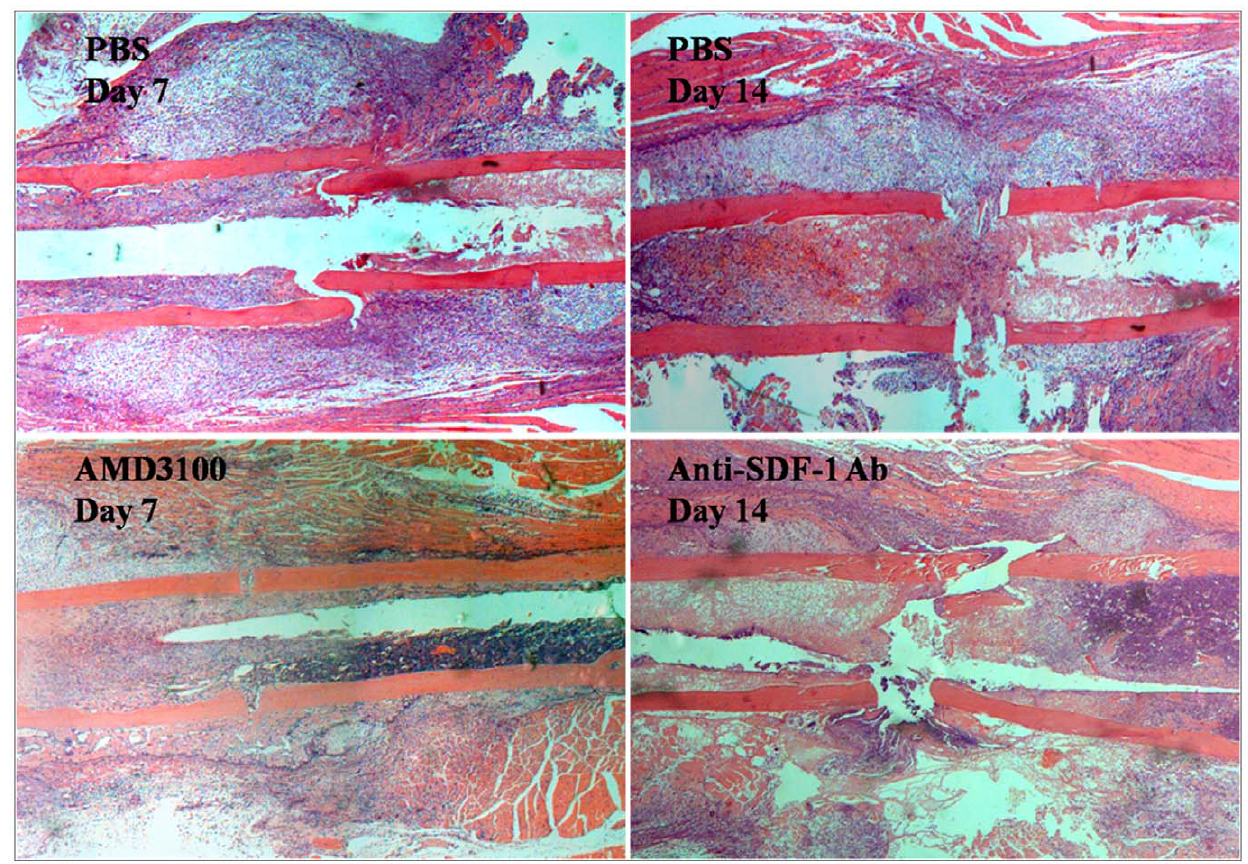
Figure 8. Loss-of-function study. New bone formation was significantly reduced at the fracture sites of the anti–SDF-1 antibody- and AMD3100- treated mice in comparison with the specimens treated with PBS on days 14 and 7, respectively. Stained with hematoxylin and